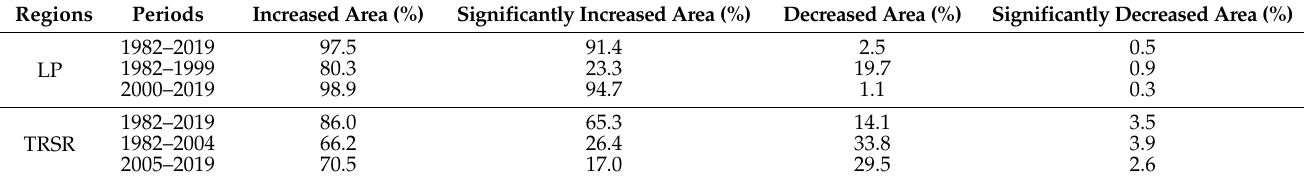
Table 2. Summary of LAI trends in the study regions.